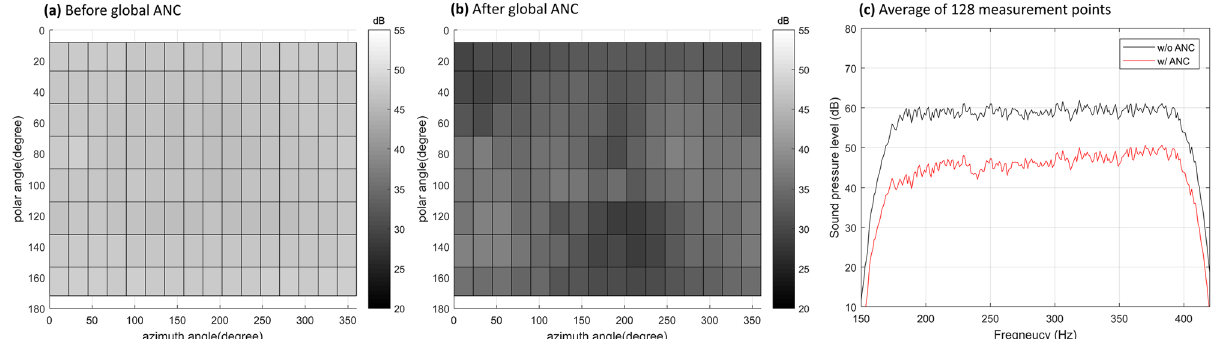
Figure 6. Global ANC experiment results at the anechoic chamber. ( a ) An average sound pressure level distribution of compound sound source in the frequency range of the interest before global ANC; ( b ) after global ANC; ( c ) Frequency domain result of an average of 128 measurement points.